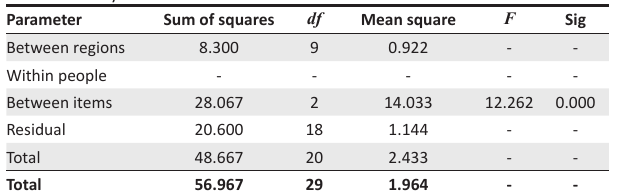
TABLE 8: Analysis of variance test. Parameter